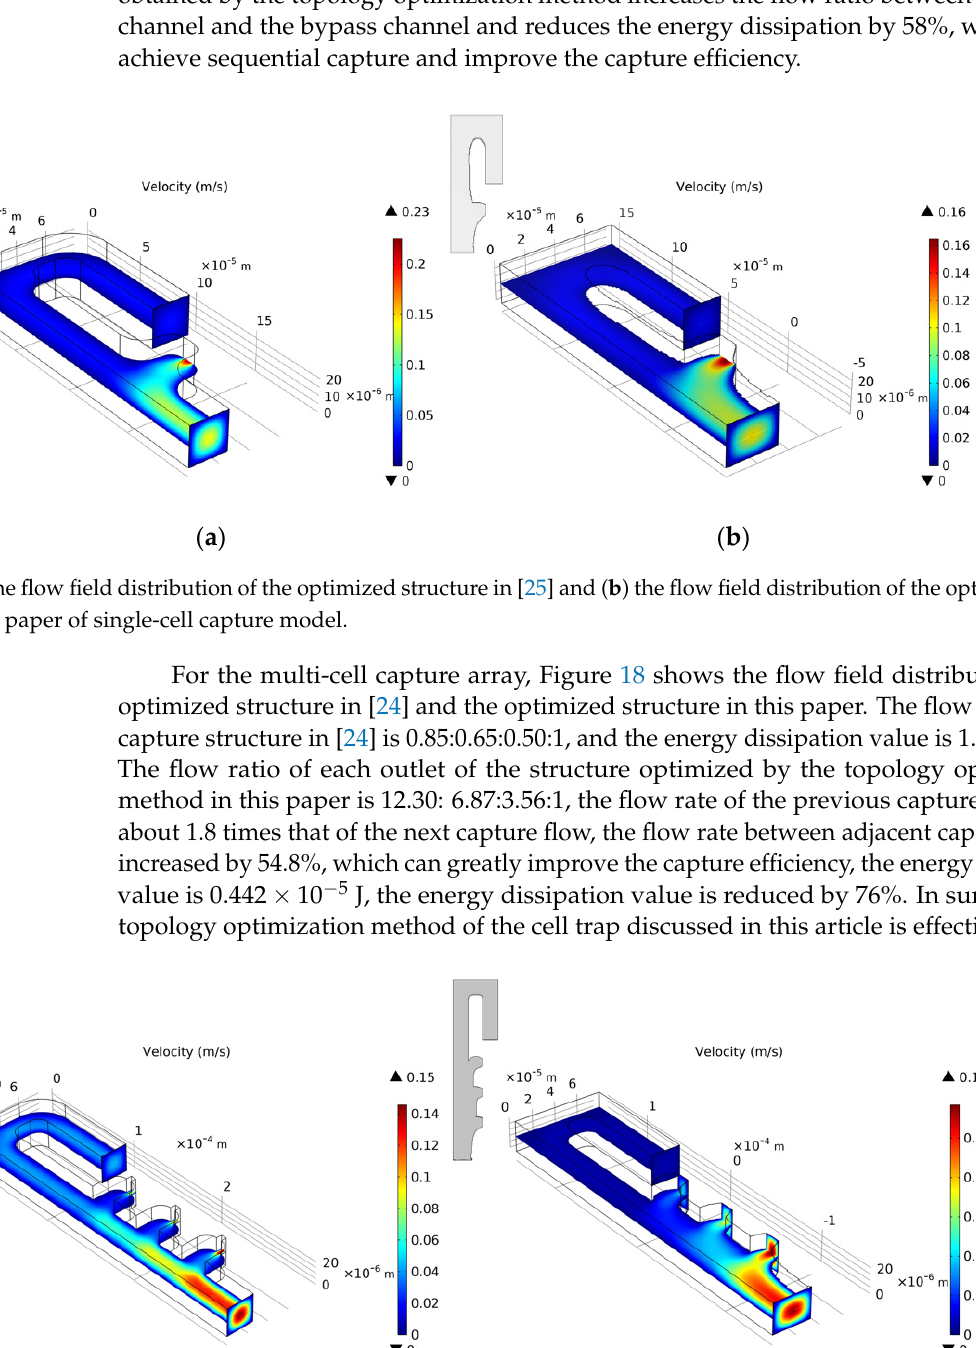
Figure 18. ( a ) The flow field distribution of the optimized structure in [24] and ( b ) the flow field distribution of the optimized structure in this paper of multi-cell capture model.